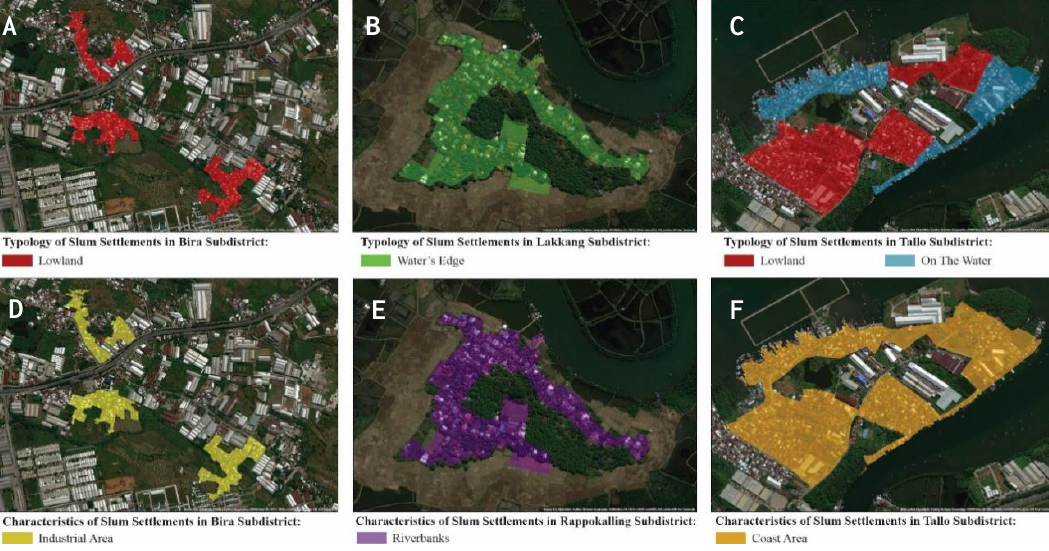
Figure 6. A, B, C, D, E, F, Example, Characteristics and Typology of Slum Settlements in Tamalanrea Figure 6. ( A – F ), Example, Characteristics and Typology of Slum Settlements in Tamalanrea District District and Tallo District. and Tallo